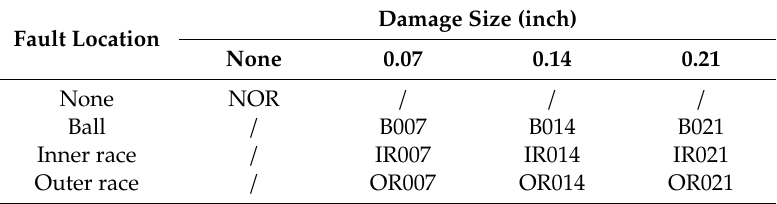
Figure 7. The bearing test rig. Table 1. Abbreviation labels of bearing conditions in Case One.